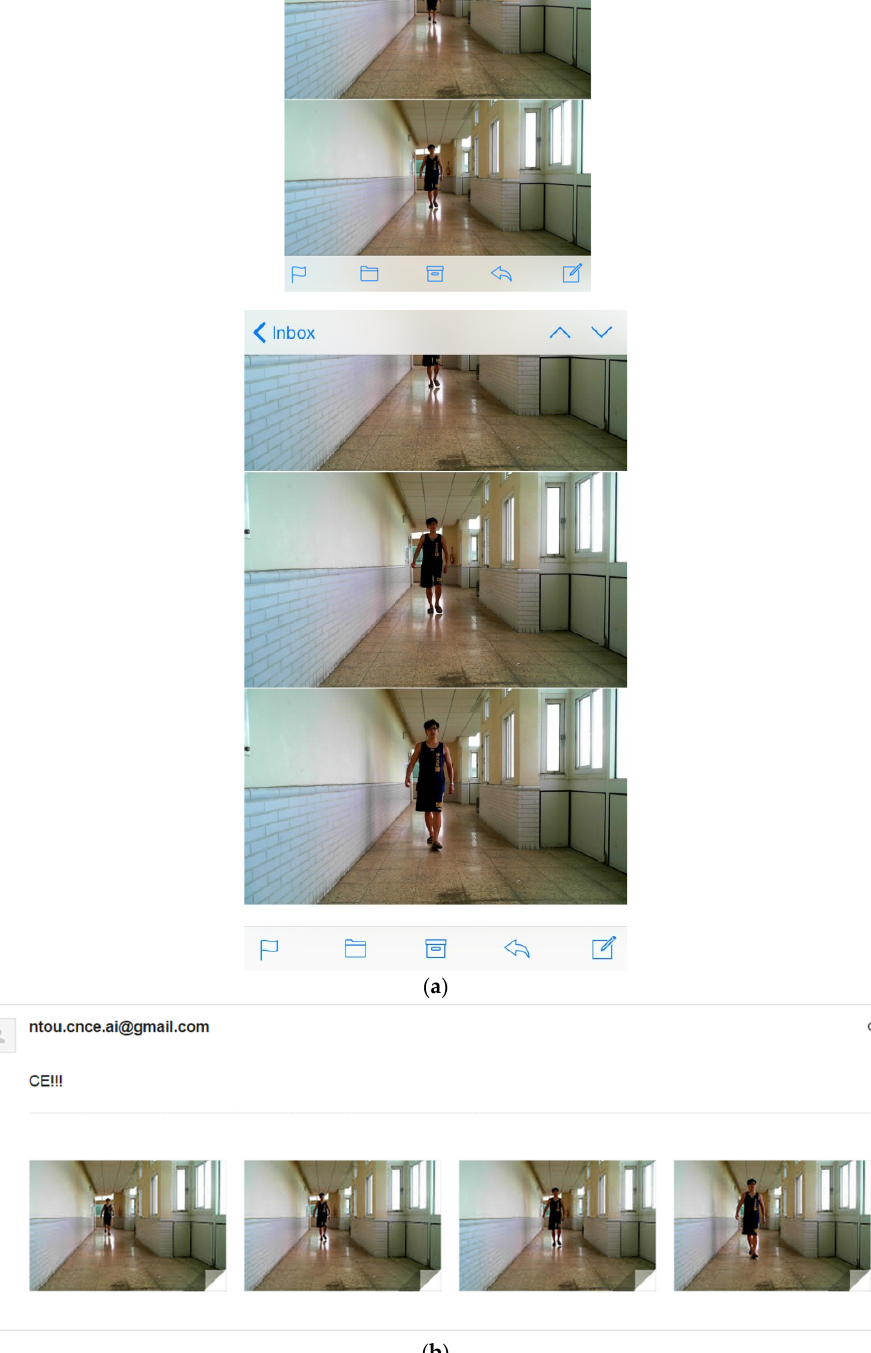
Figure 32. The first robot sends instant images to the control center and to the user’s smartphone. ( a ) Smartphone receives notification message about the intruder; ( b ) remote control center receives notification message about the intruder.